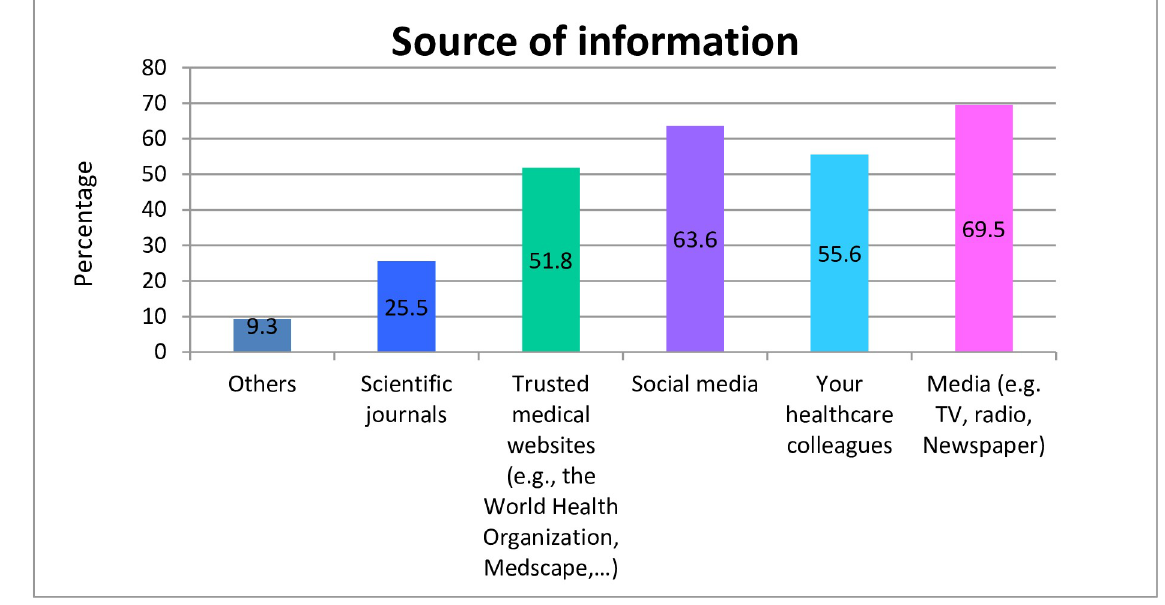
Fig 1. Source of information regarding